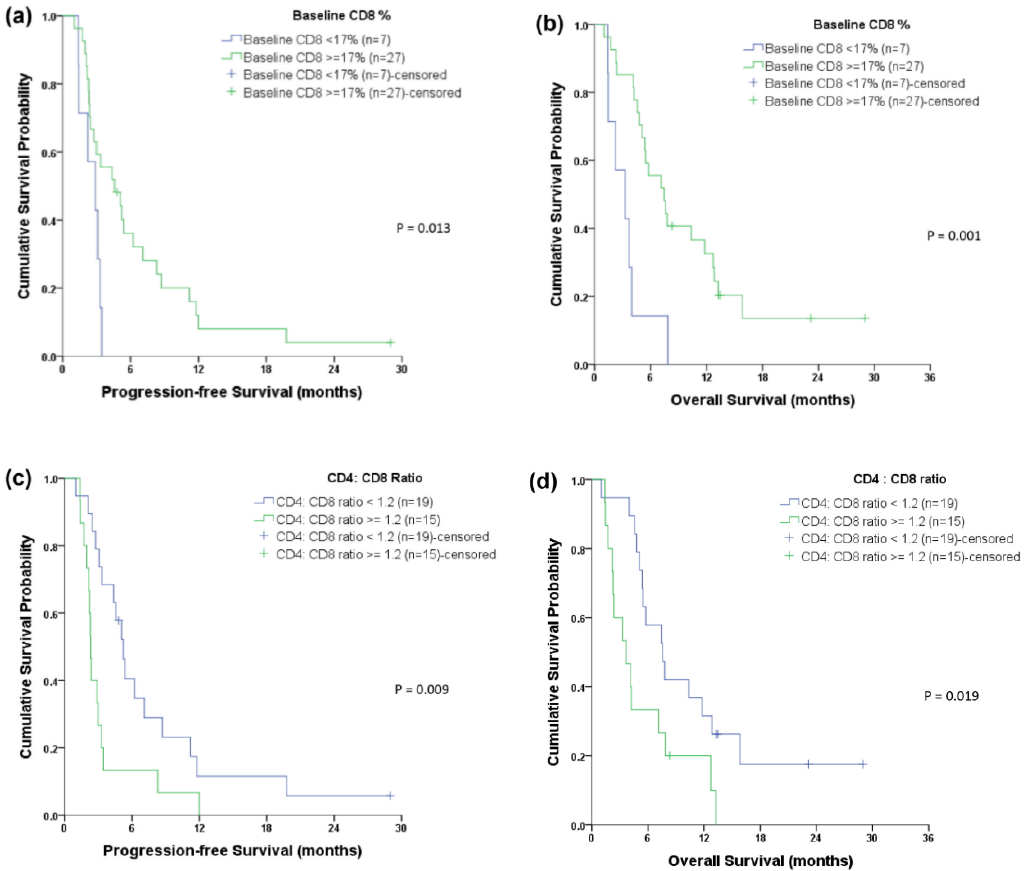
Figure 4. Kaplan-Meier curves for the survival analyses. A higher baseline CD8 + proportion was associated with better ( a ) progression-free survival (PFS) and ( b ) overall survival (OS). A lower baseline CD4: CD8 ratio was associated with better ( c ) PFS and ( d ) OS.